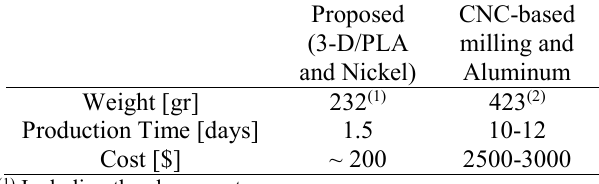
Table 5: Comparison of manufacturing